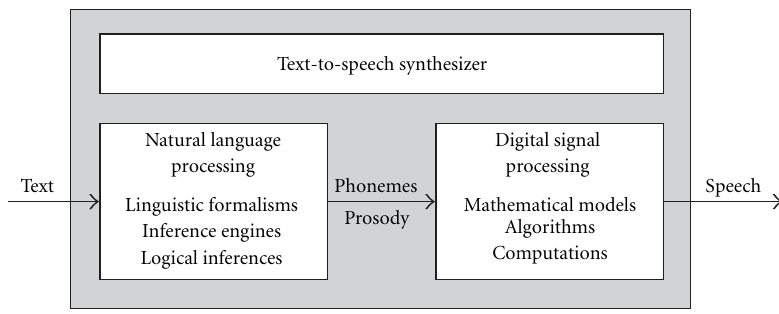
Figure 9: Overview of the system.